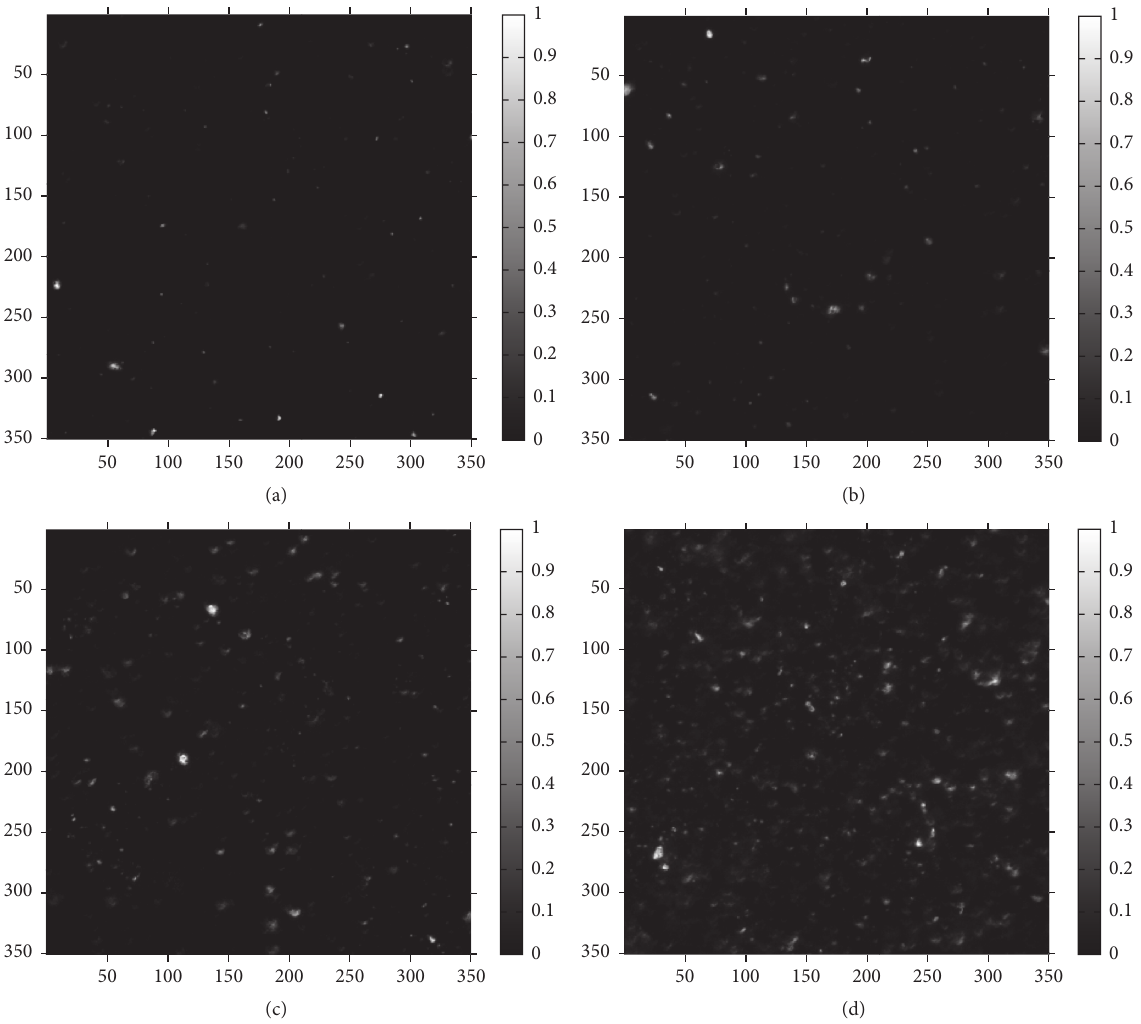
Figure 5: The melamine distribution map predicted by CLS applied to the NIRM imaging data. Only one sample was taken as an example of each concentration. (a), (b), (c), and (d) represent 5, 10, 25, and 50 g kg −1 of melamine,